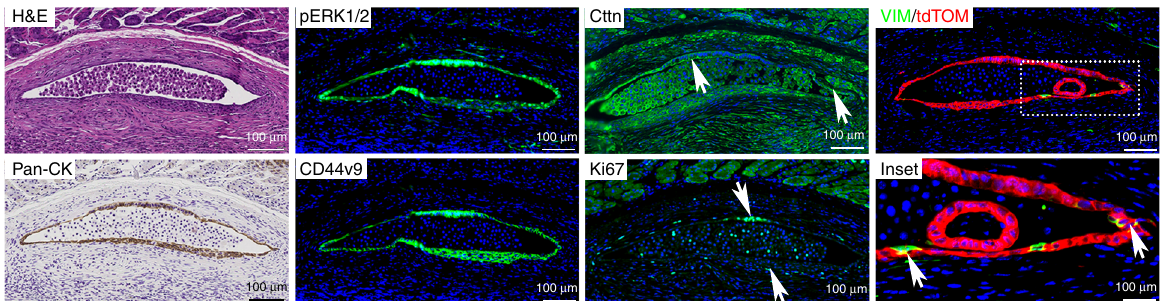
Fig. 3 Orthotopic implantation of Meta4 organoids in mice. H&E stained slides show engrafted area in the stomach muscularis layer at 1 month after implantation. Immunostaining for an epithelial cell marker, pan-cytokeratin (pan-CK), a marker for Kras signaling downstream, phospho-ERK1/2 (pERK1/ 2), an EMT marker, Cortactin (CTTN), a metaplasia and gastric cancer marker, CD44v9, a proliferation marker, Ki67 and the red fl uorescent protein tdTomato (tdTOM, red) with Vimentin (VIM, green). Dotted box indicates enlarged inset area. Scale bars indicate 100 μ m. Source data are provided as a Source Data fi